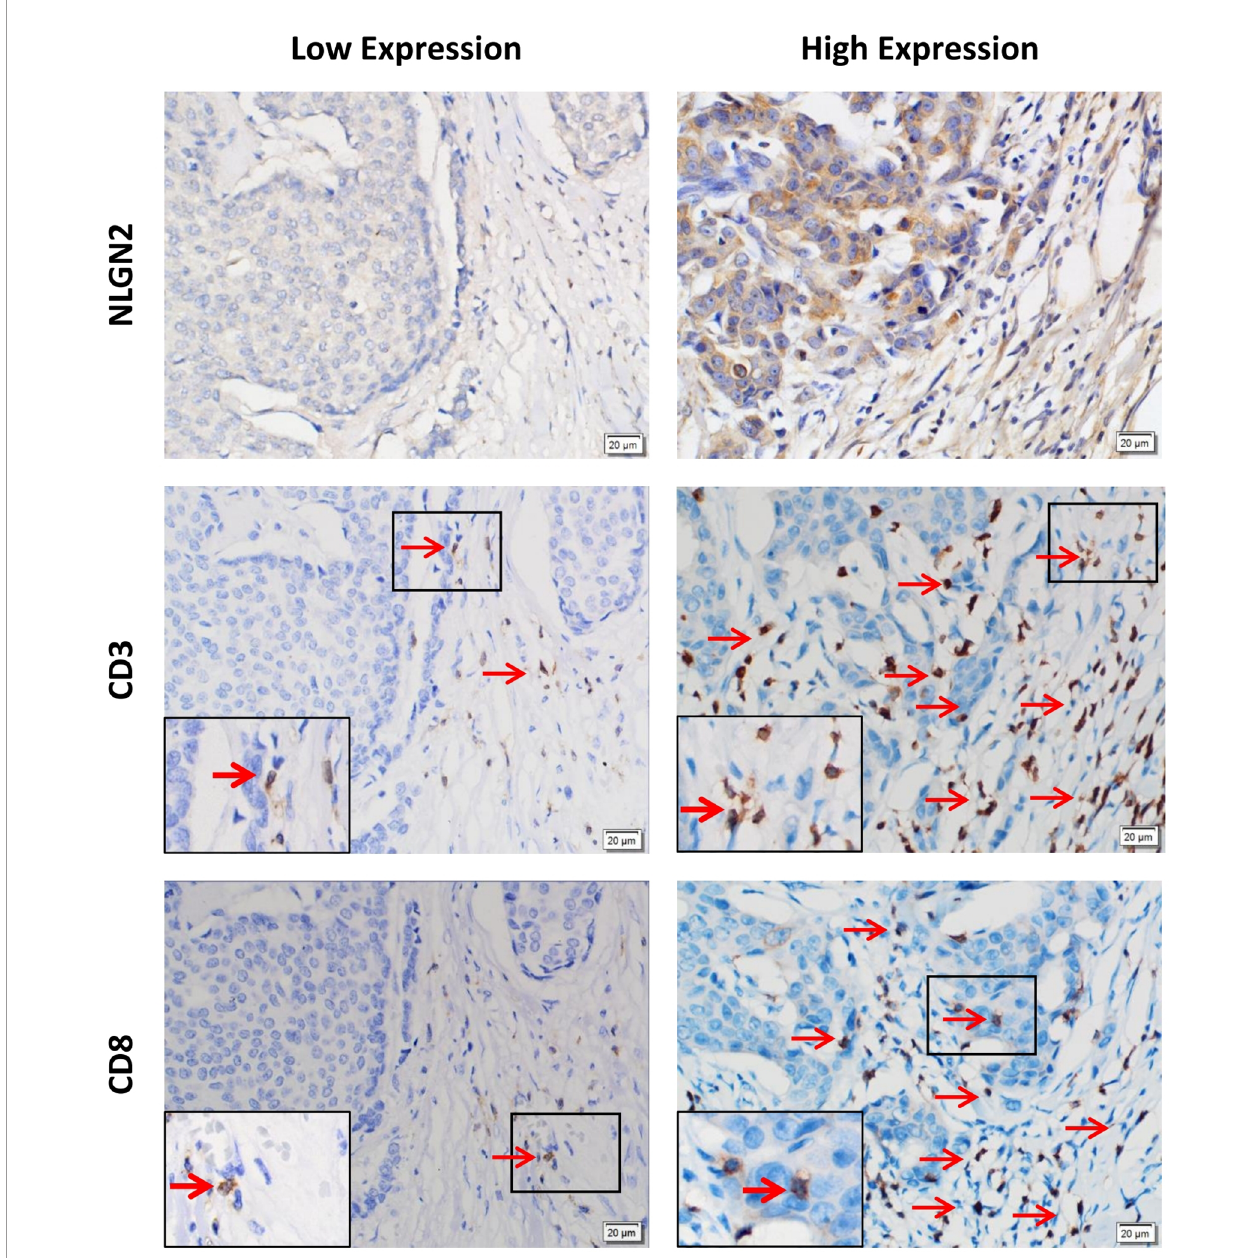
FIGURE 5 | Association of the expression levels of NLGN2, CD3 and CD8 in breast cancer. Representative images of immunohistochemical staining showing in situ expression of NLGN2, CD3 and CD8 in breast cancer tissue specimens. Left panels, low expression of NLGN2 in breast tumor tissue, and CD3+ and CD8+ T cells in the same tissue. Right panels, high expression of NLGN2 in breast tumor tissue, and CD3+ and CD8+ T cells in the same tissue. The arrows point to CD3+ or CD8+ lymphocytes. All photos are at 400× original magni fi